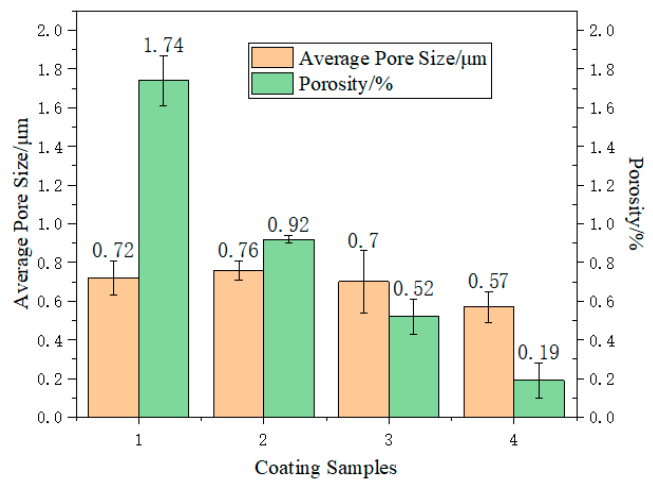
Figure 7. Average pore size and porosity of the coating samples.